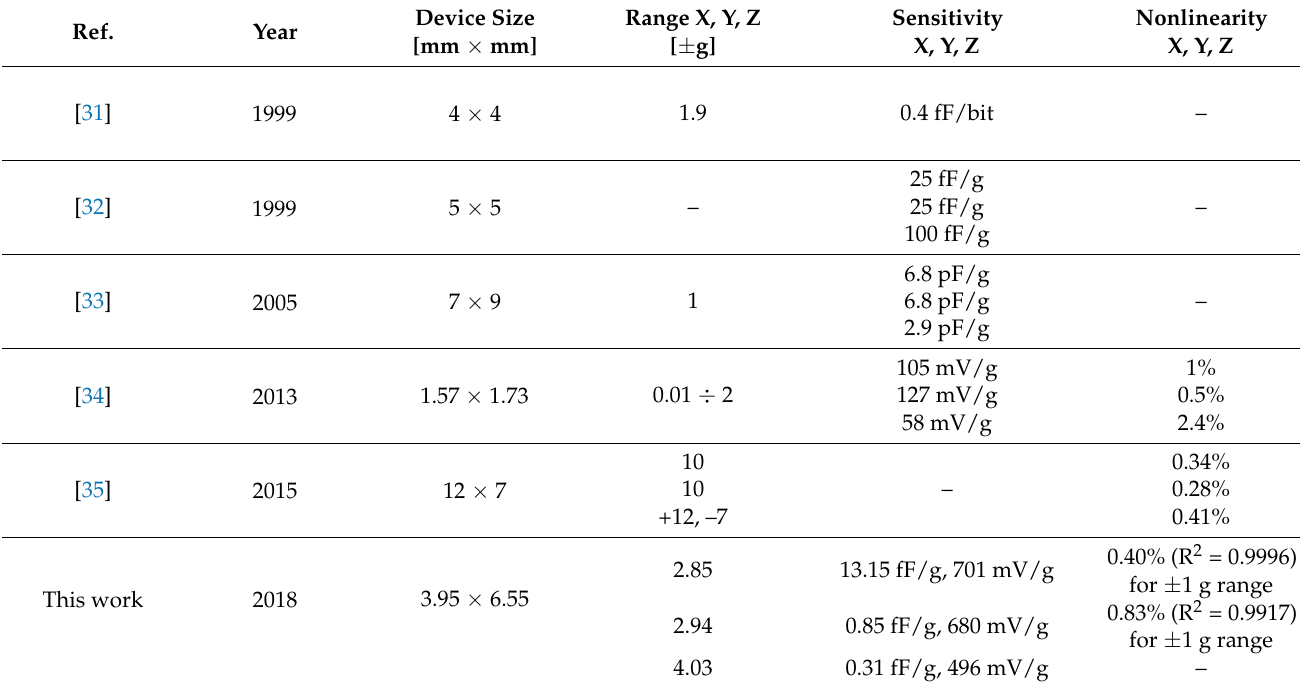
Table 3. Parameters of three-axis multiple seismic mass